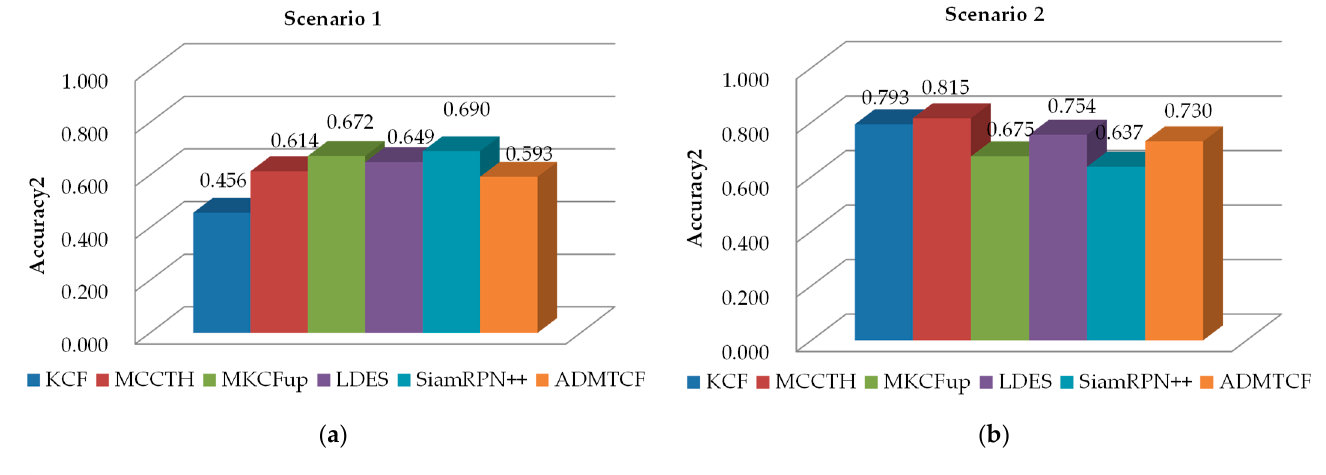
( d ) Figure 13. Tracking accuracy using Metrics-1: ( a ) scenario 1; ( b ) scenario 2; ( c ) scenario 3; ( d ) sce-